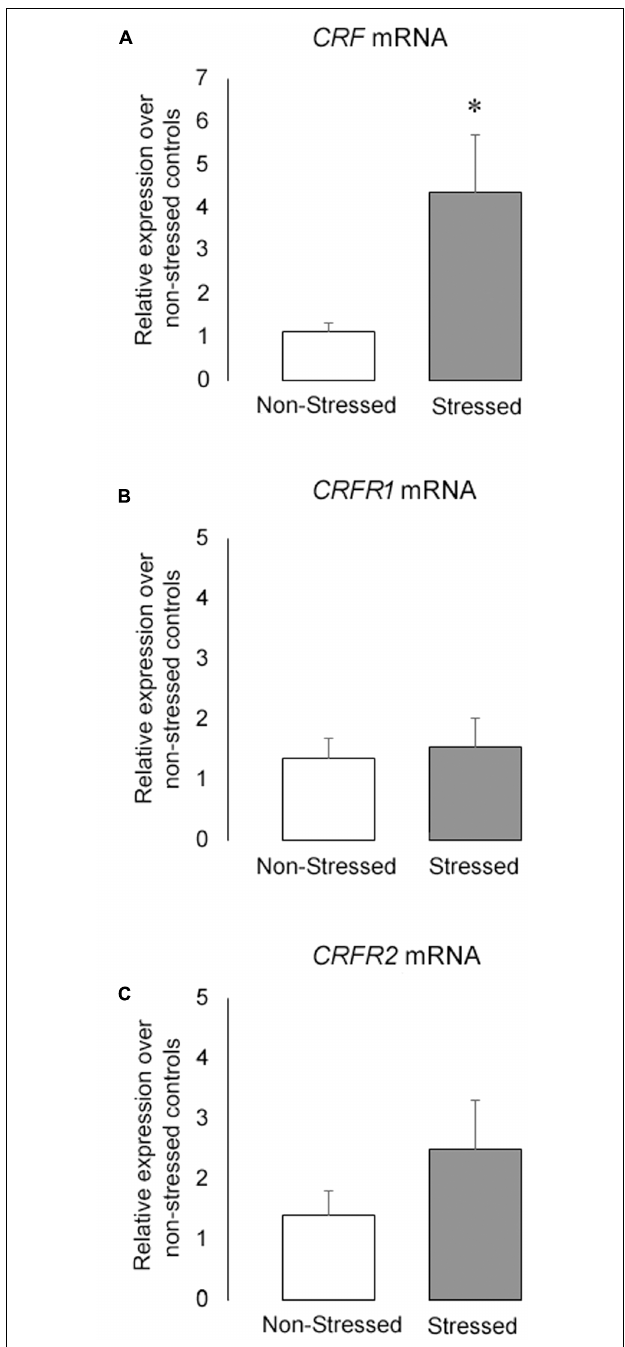
FIGURE 7 | (A) CRF (B) CRFR1 and (C) CRFR2 mRNA levels in the BNST of non-stressed controls and socially defeated mice measured by qPCR. Gene expression was normalized to GAPDH using the (cid:49)(cid:49) Ct method and relative to control non-stressed group. Data are mean ± SEM. ∗ versus non-stressed controls. p < 0.05, n = 6 mice per